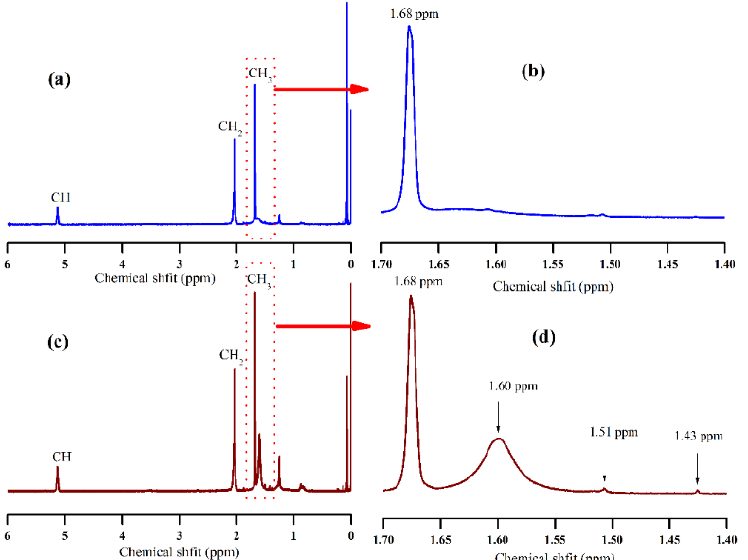
Figure 2. 1 H NMR spectra for NR samples coagulated by ( a ) acetic acid and ( c ) brown sugar. Spectra ( b , d ) are the partial enlargement of ( a , c ) at chemical shift range from 1.70 to 1.40, respectively.